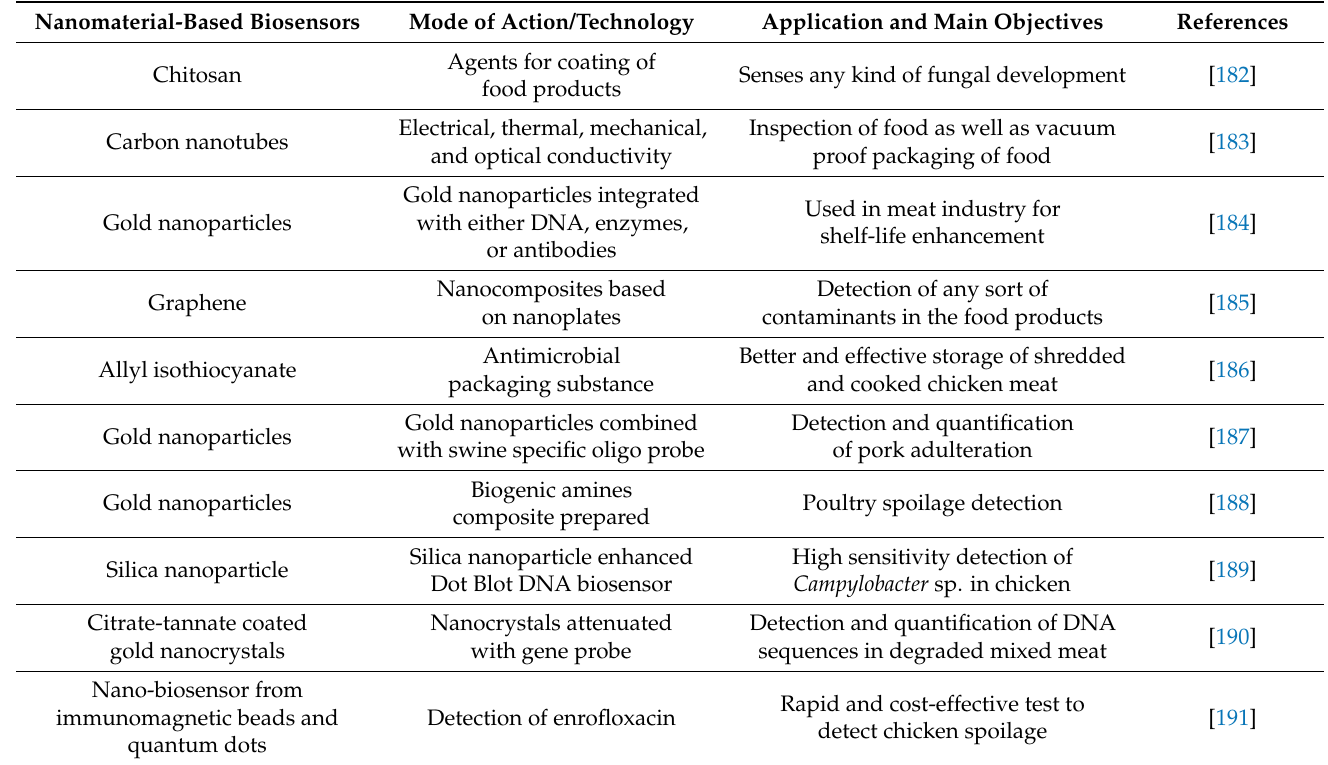
Table 3. A non-exhaustive list of some nanobiosensors used in the field of food/meat technology. Nanomaterial-Based